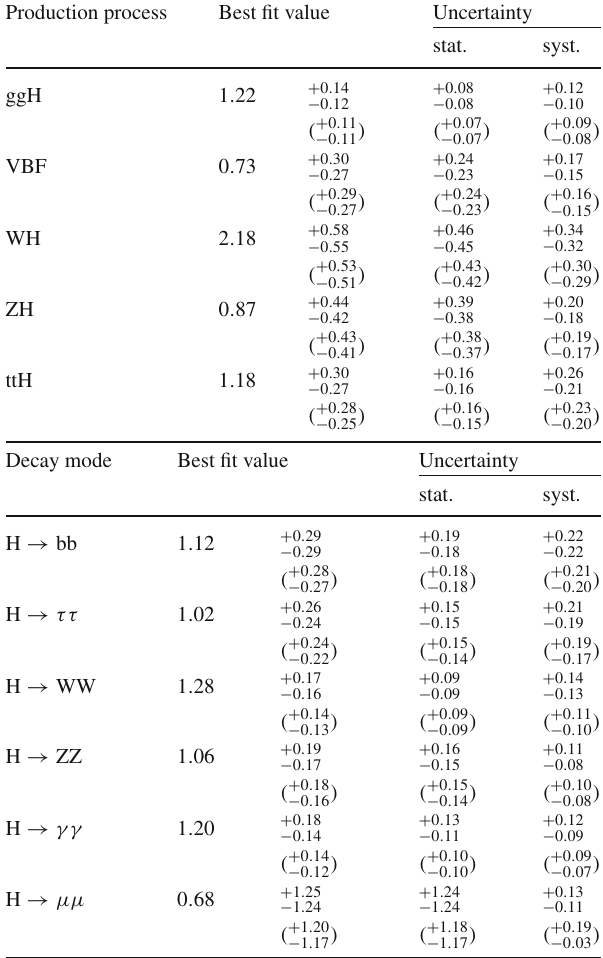
Table 2 Best fit values and ± 1 σ uncertainties for the parametrizations with per-production mode and per-decay mode signal strength modi- fiers. The expected uncertainties are given in brackets Production process